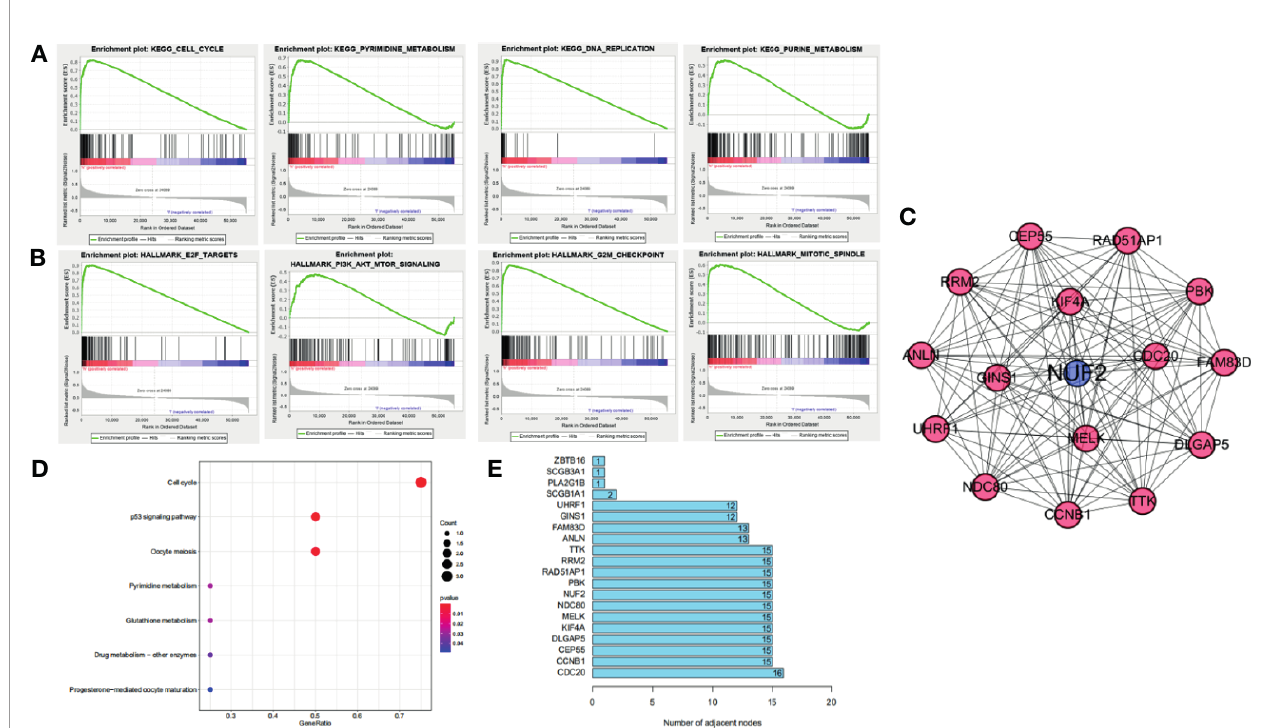
FIGURE 5 | (A, B) Gene set enrichment analysis of NUF2 in KEGG and Hallmark collections. (C) The signi fi cant module via MCODE in the Cytoscape which contain the nodes with most edges. (D) The most signi fi cant pathway in the module via pathway enrichment analysis. (E) The number of edges about each node in the